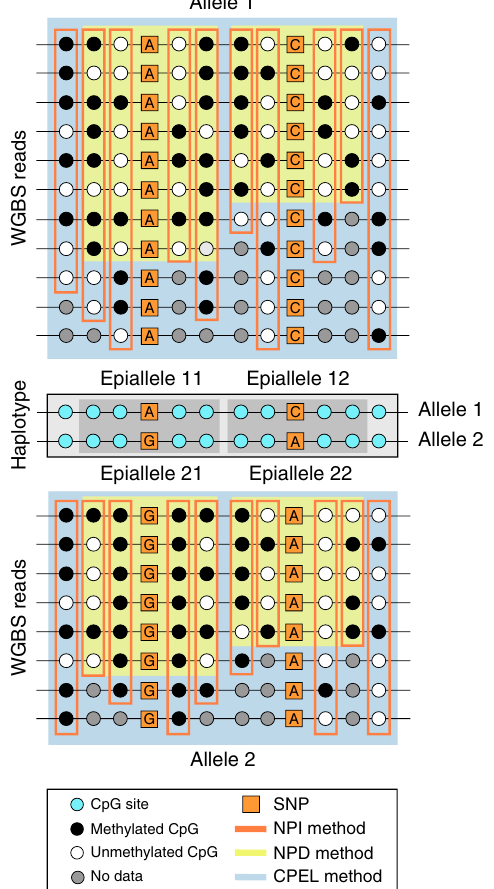
Fig. 1 Comparison of hap-ASM analysis methods. WGBS reads (rows) corresponding to each homologous allele of a haplotype are used by each method to estimate the probability distribution of methylation (PDM) within each allele. The NPI method provides an empirical estimate of the PDM at each CpG site using WGBS observations of its methylation state (orange rectangles). The NPD method provides an empirical estimate of the joint PDM within an epiallele, composed of a few CpG sites (usually 4) around an SNP, using only full WGBS observations of its methylation state (yellow rectangles). The CPEL method performs haplotype-dependent allele-speci fi c methylation analysis by estimating the joint PDM at all CpG sites within a homologous allele using the entire set of WGBS data (blue rectangles), thus utilizing all available methylation information and allowing modeling of the cooperative effect of multiple SNPs on DNA